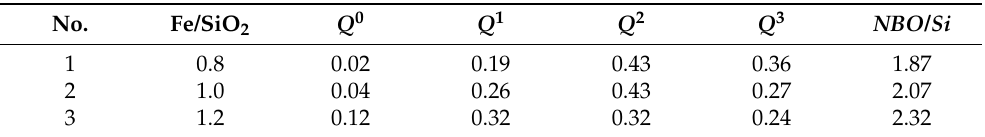
Table 2. Deconvolution results of the characteristic peaks of Raman spectra of samples with varying Fe/SiO 2 ratios at Fe 2 O 3 content of 8 wt% .